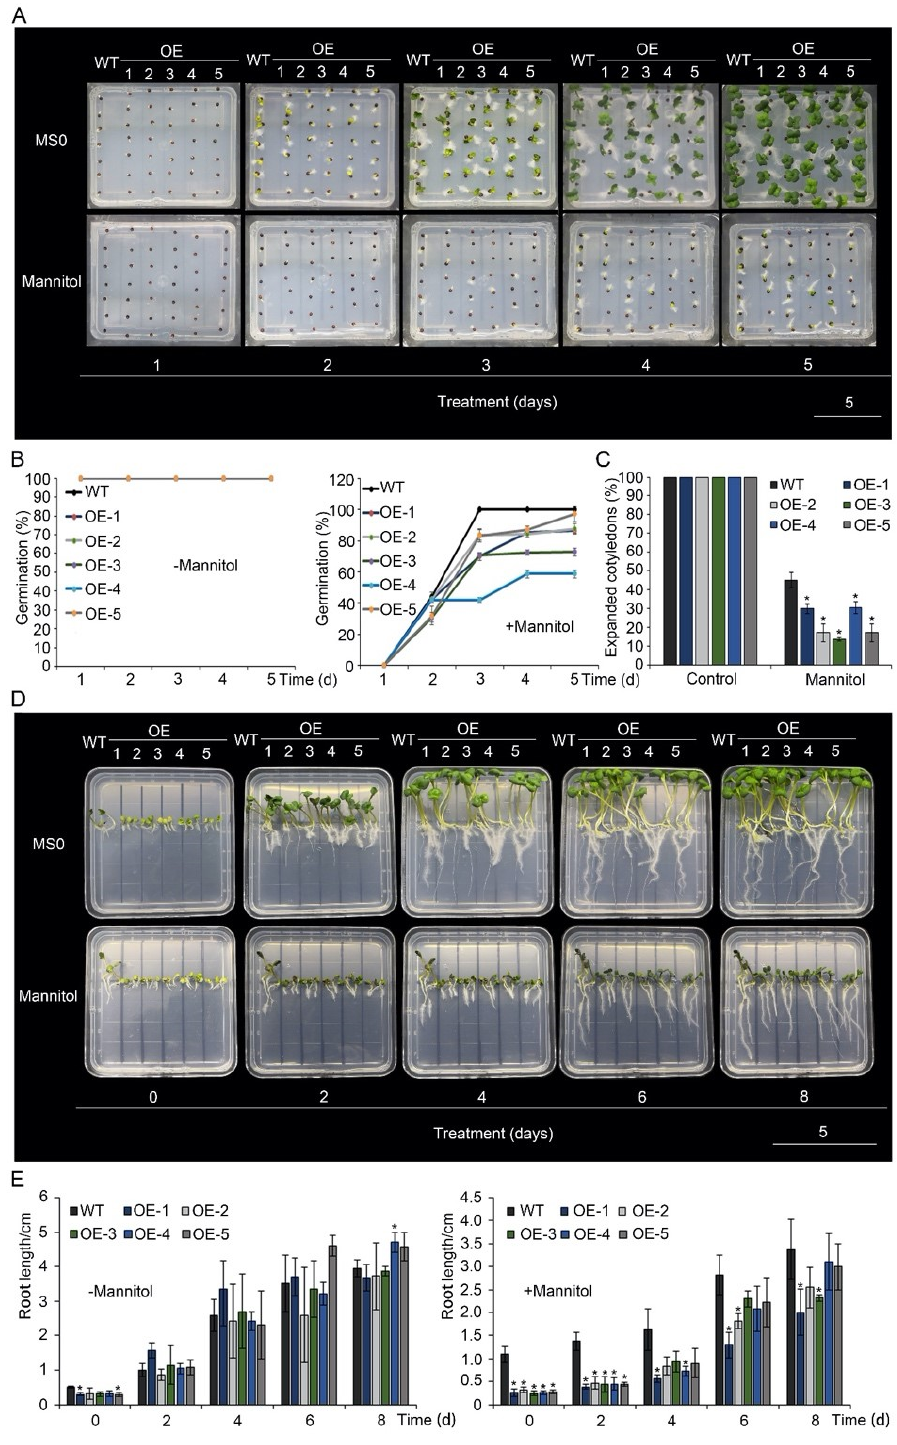
Figure 2. Drought-stress responses of p35S::BnA.JAZ5 rapeseed plants. ( A ) Phenotypes of germinated six-day-old overexpressing lines under 400 mM mannitol treatment. ( B ) Seed germination rate of the five overexpressing lines under 400 mM mannitol treatment. ( C ) The percentage of wild-type and p35S::BnA.JAZ5 rapeseed seedlings with expanded cotyledons was scored 5 d after stratification on MS medium supplemented with 400 mM mannitol. ( D ) Phenotypes of root elongation of five overexpressing lines under 400 mM mannitol treatment. ( E ) Root length of five overexpressing lines under 400 mM mannitol treatment. Error bars represent standard errors. Asterisks indicate significant differences between wild-type and p35S::BnA.JAZ5 lines ( p <